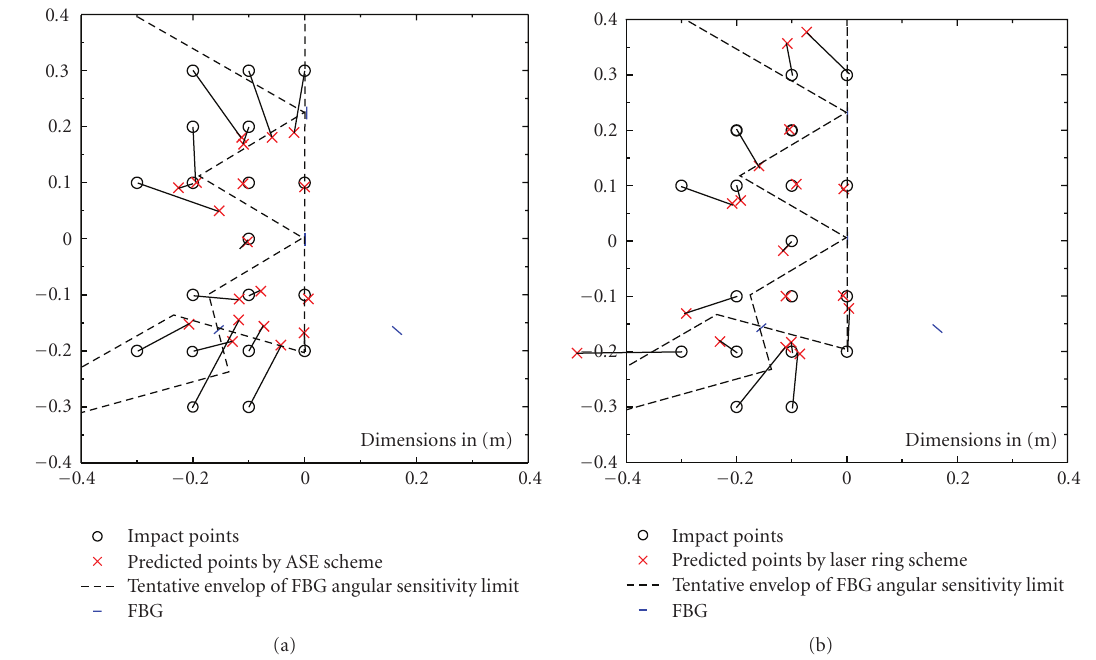
Figure 7: Comparison of the actual and calculated impact locations on the aluminum plate using (a) the ASE light source scheme and (b) the laser ring scheme.